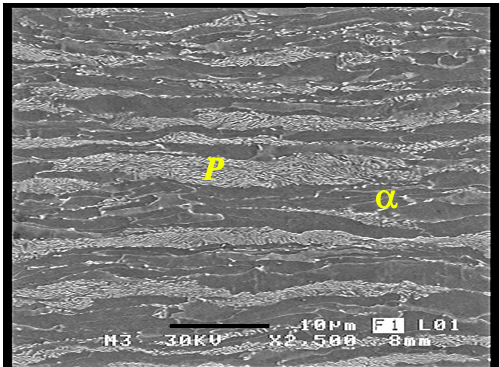
Figure 1. SEM micrograph by secondary electrons (SE) showing details of the distortion caused on the cementite lamellar of pearlite by the severe plastic deformation. Micrograph taken in the cross section (RD-ND plane) of the strip. Sample etched by 2% Nital. RD and ND refer to the rolling and to the normal directions,